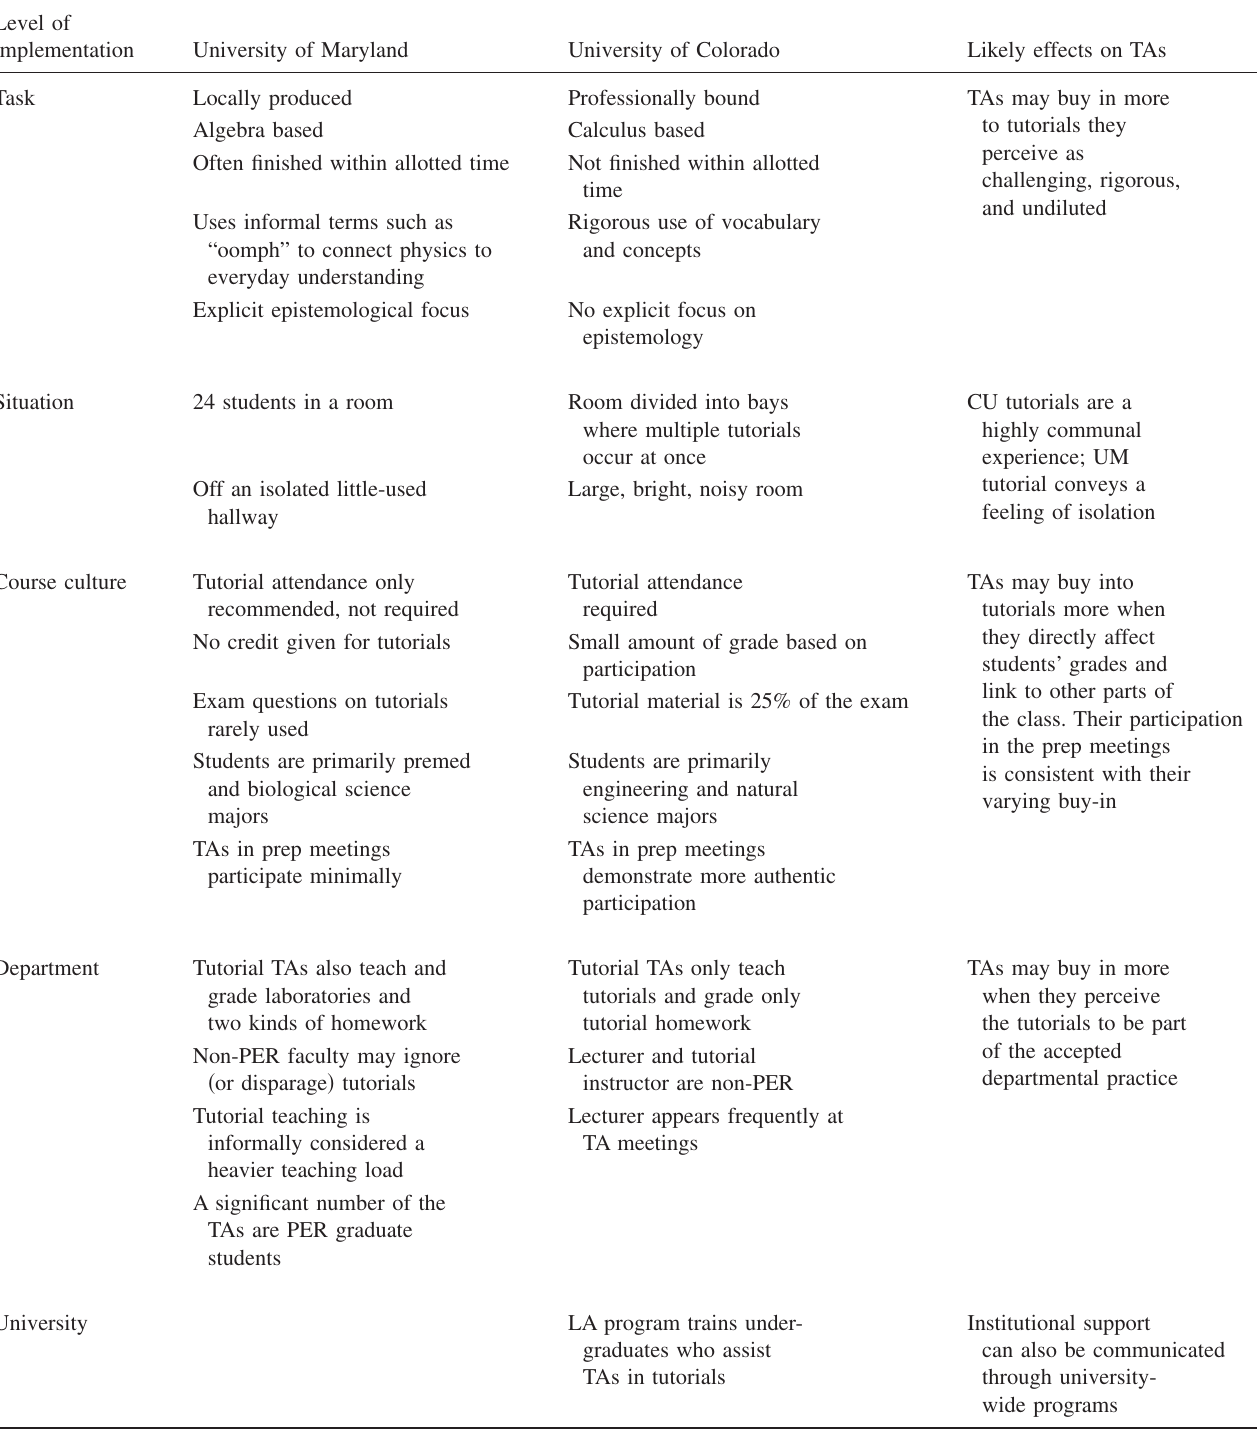
TABLE I. A summary of the differences in social and environmental context at UM and CU and their likely effects on TAs. Level